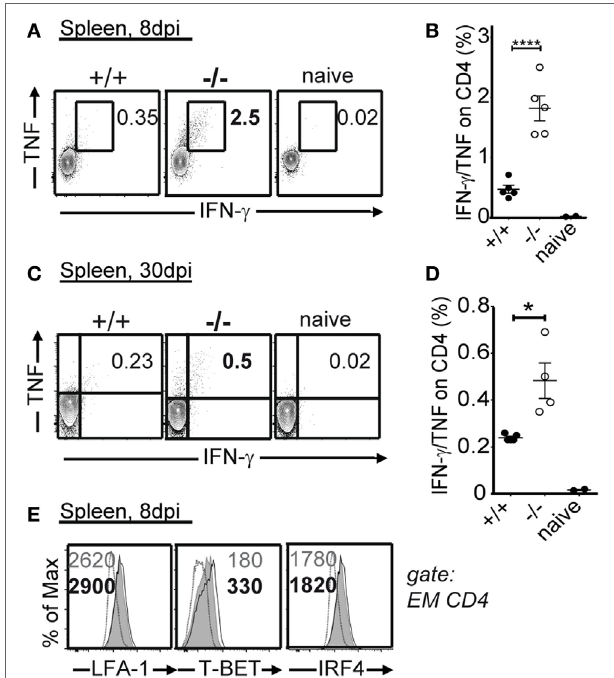
FigUre 5 | PTPN22 − / − mice have improved antiviral CD4 T responses following lymphocytic choriomeningitis virus clone 13 infection. PTPN22 + / + (black circles) and PTPN22 − / − (white circles) mice were infected as in Figure 1 . (a–D) Production of IFN- γ and TNF by GP 61–80 -specific CD4 T cells was performed by intracellular cytokine staining at 8 (a,B) and 30 days post infection (dpi) (c,D) . (e) LFA-1, T-BET, and IRF4 levels were determined in PTPN22 + / + and PTPN22 − / − CD44 + CD4 cells 8 dpi.